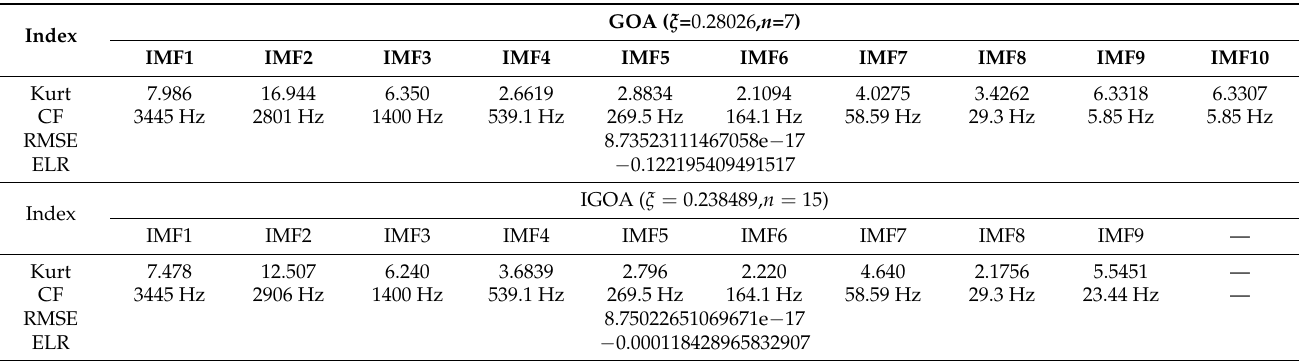
Figure 18. Decomposition results evaluation of outer ring slight damage signal.